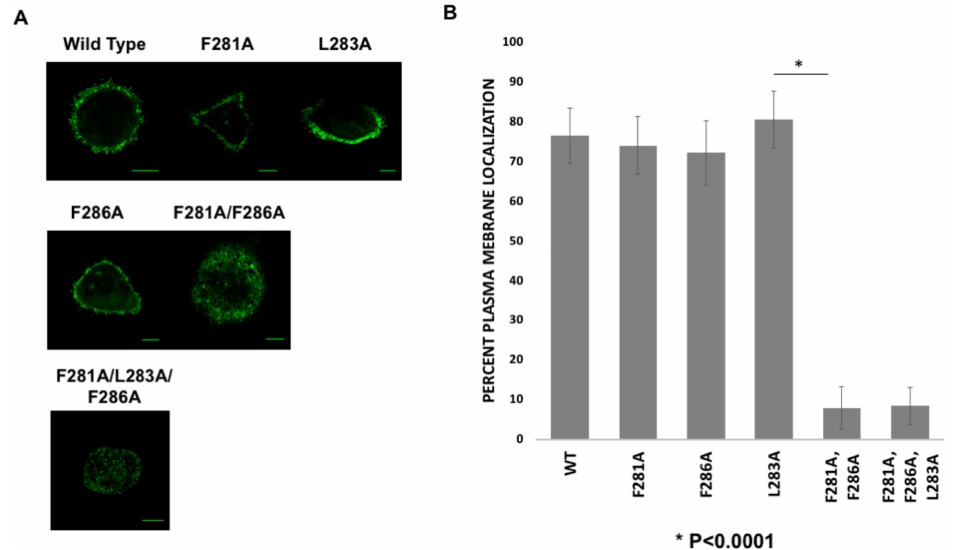
Figure 2. Cellular localization of WT mVP40 and hydrophobic residue mutants. ( A ) COS-7 cells expressing EGFP fusion constructs of wild type (WT) mVP40 and mutants. Cells were imaged 14 h post transfection. ( B ) COS-7 cells were quantified for the average plasma membrane localization for the respective constructs. Three independent experiments were performed for each construct. Error bars represent standard error of the mean. (C.I. = 95%). Scale bar = 10 µ